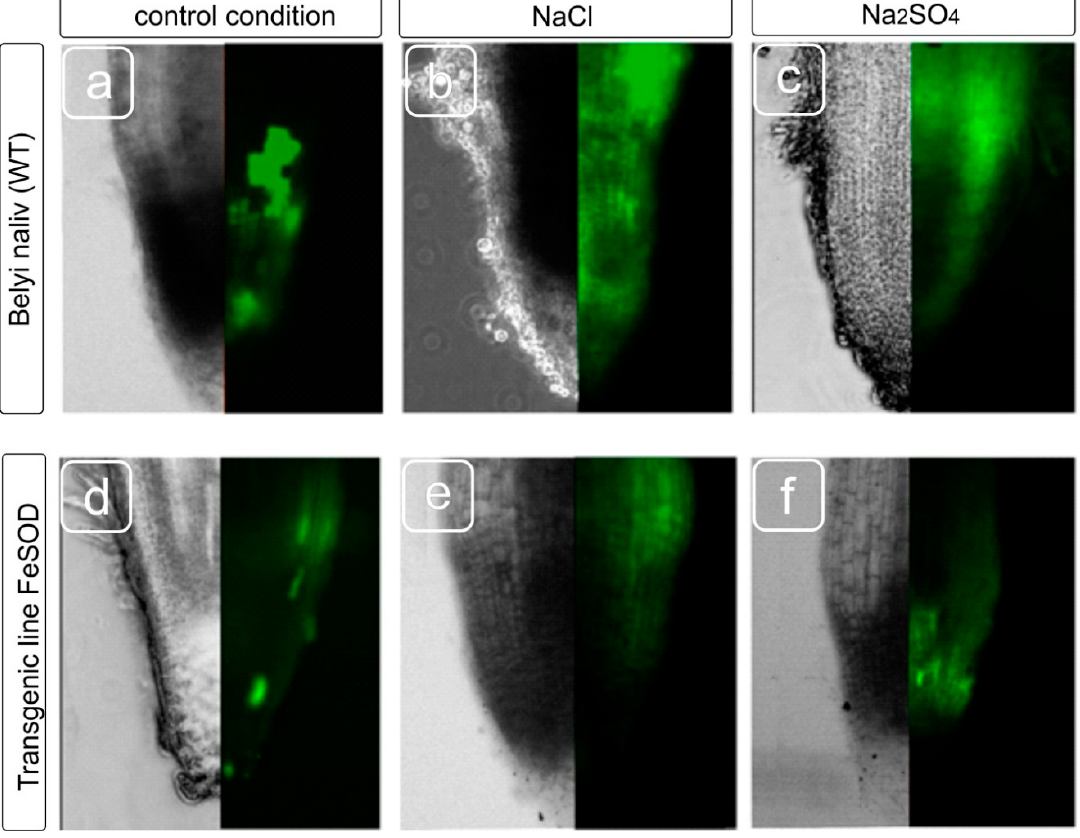
Figure 3. Distribution of reactive oxygen species (ROS) in the different zones of tomato roots. WT ( a – c ) and transgenic line 19 ( d – f ) plants were grown without, and with the addition of NaCl and Na 2 SO 4 . A change in the localization of ROS in the meristem and cap cells of the root tip is shown as a modification of fluorescence.